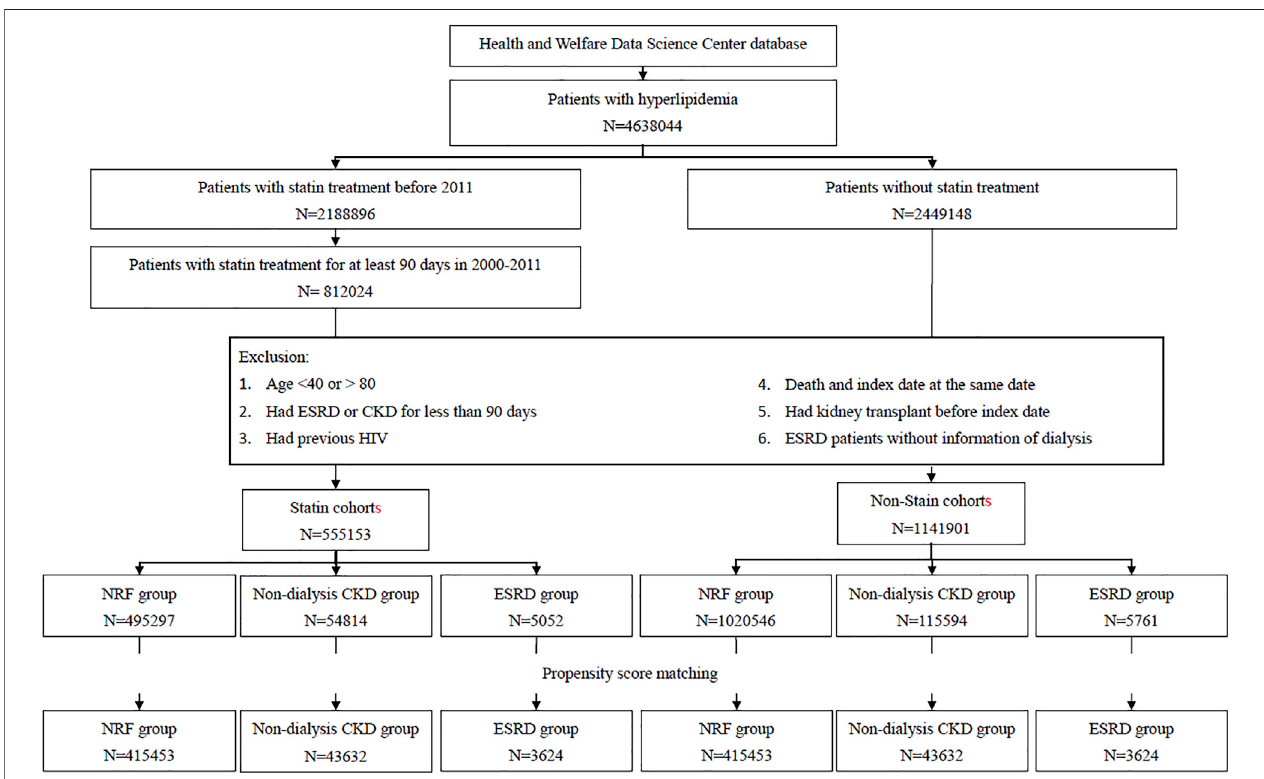
FIGURE. 1 | Flow chart for establishing study